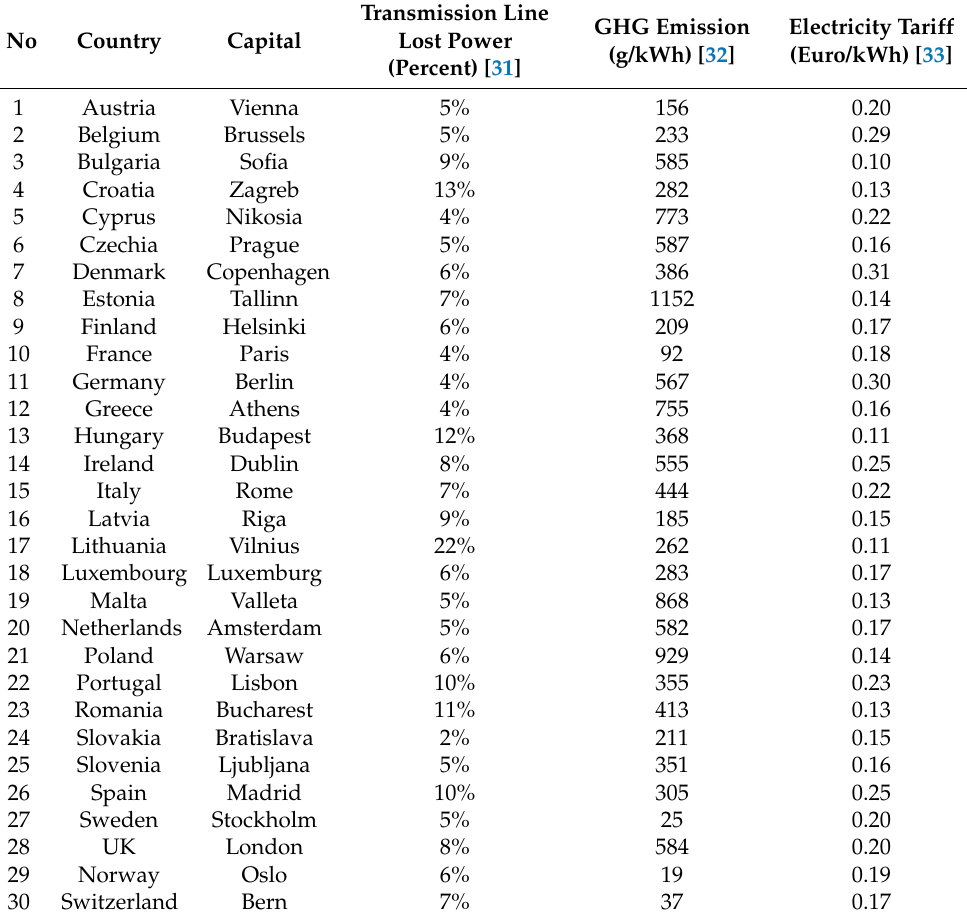
Table 1. Electricity tariffs, GHG and electric power transmission and distribution losses of the European